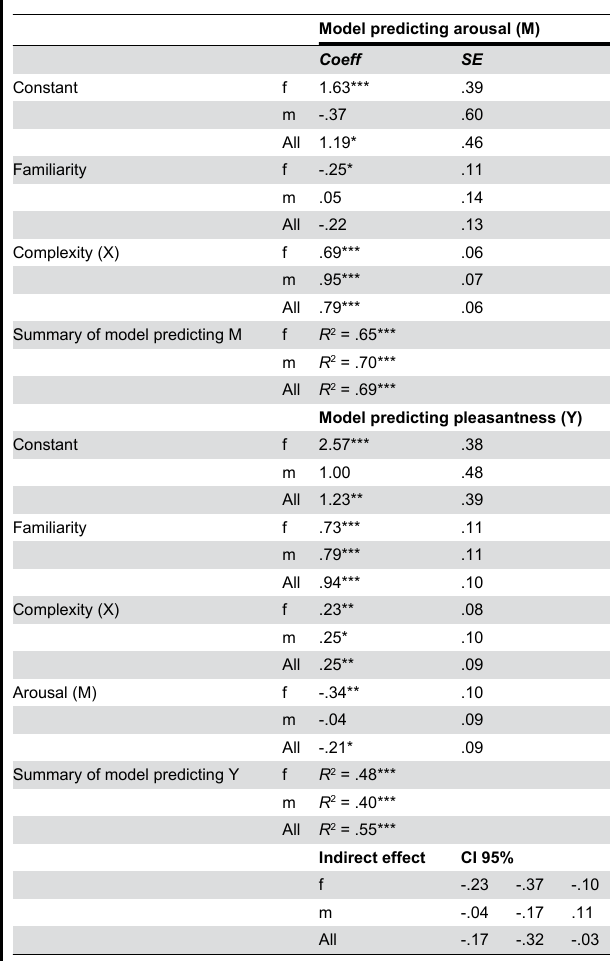
Table 10. Indirect effect of complexity (X) on pleasantness (Y) through arousal (M) with familiarity as a covariate, calculated for piano solo music (N =